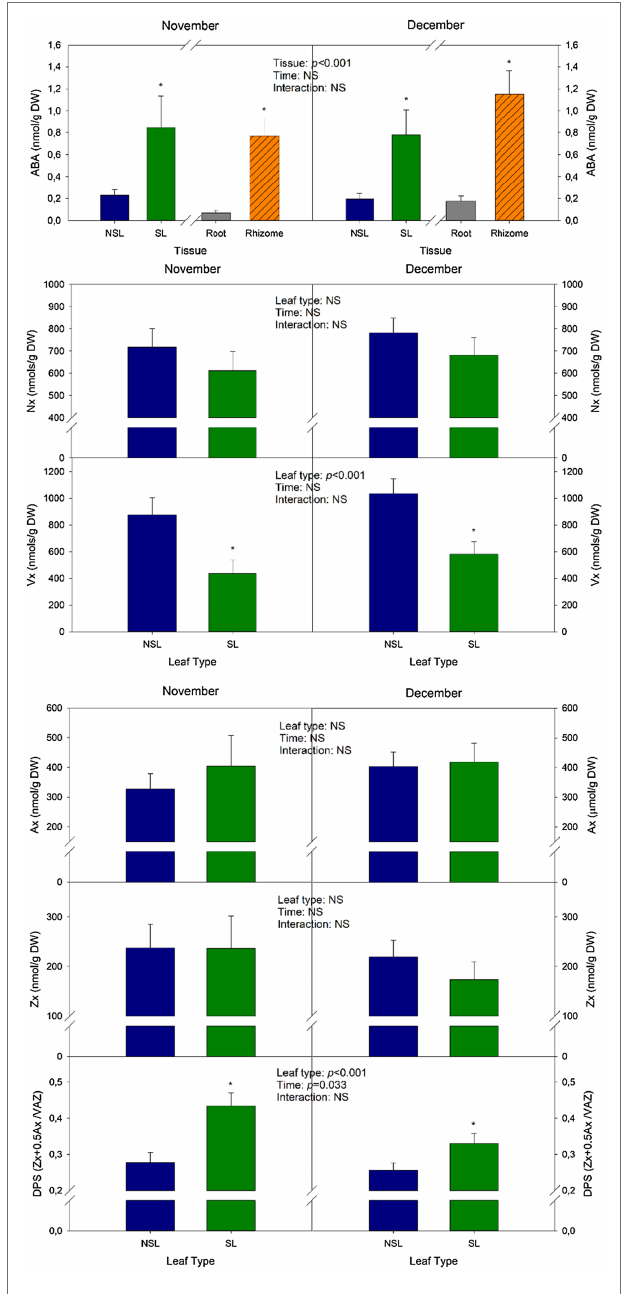
FIGURE 3 | Changes in abscisic acid (ABA) and carotenoid contents during cold-induced leaf senescence. ABA, violaxanthin (Vx), neoxanthin (Nx), antheraxanthin (Ax), zeaxanthin (Zx) contents, and the de-epoxidation state of the xanthophyll cycle (DPS) of senescent and non-senescent leaves. Values of p from the two-way mixed factorial analysis are shown, including the factor Time , Leaf type/Tissue , and their interaction. An asterisk indicates differences between leaf types or root tissue types. Data show the mean ± SE of n = 12 individuals. NSL, non-senescent leaf; SL, senescent